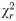
Results from reweighting the simulation with the optimized force field (λ = 1.06).(A) Fit to SAXS data with adjusted force fields before (black) and after reweighting at θ = 500 (green). (B) χr2 vs. ϕeff for selection of θ. (C) Rg calculated from structures during the simulation, including the mean value (black), experimental Rg from SAXS (red), and mean Rg from the reweighted ensemble (green). Corresponding histograms in the right panel. (D) Calculated D13 before and after reweighting.